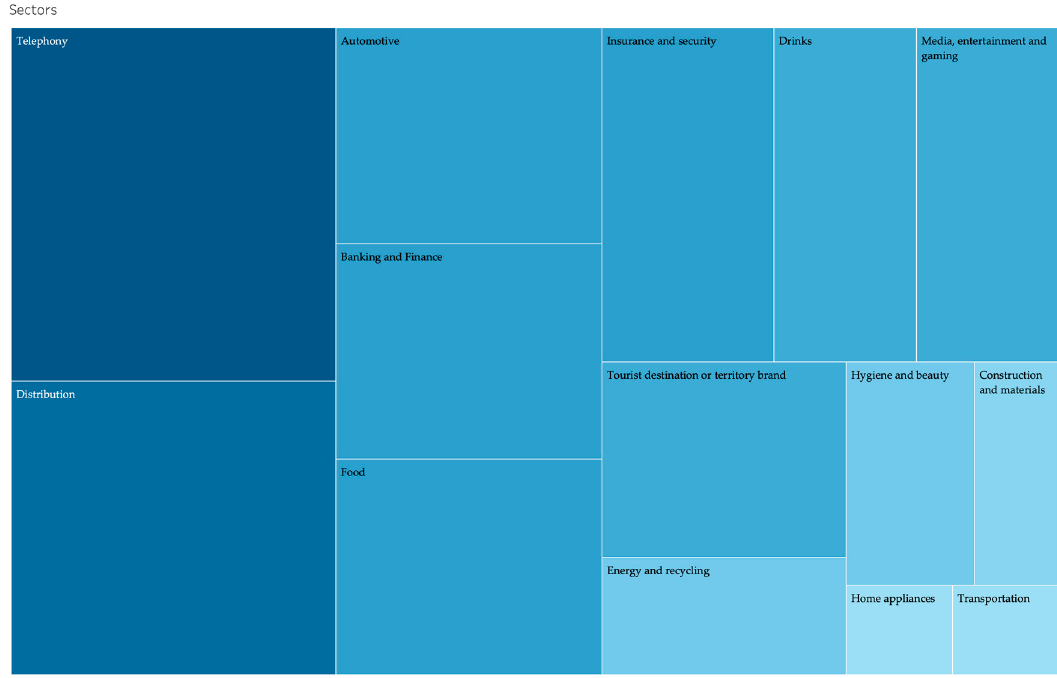
Figure 4. Advertising grouped by sectors.